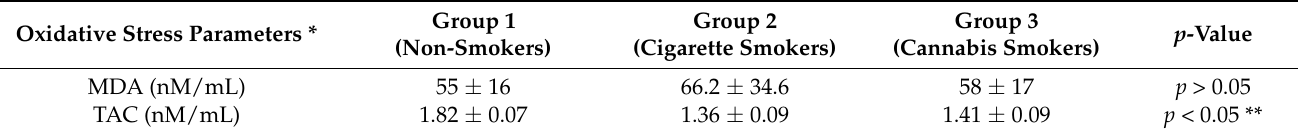
Table 4. Malondialdehyde plasma concentration and total antioxidant capacity of all study groups. Oxidative Stress Parameters